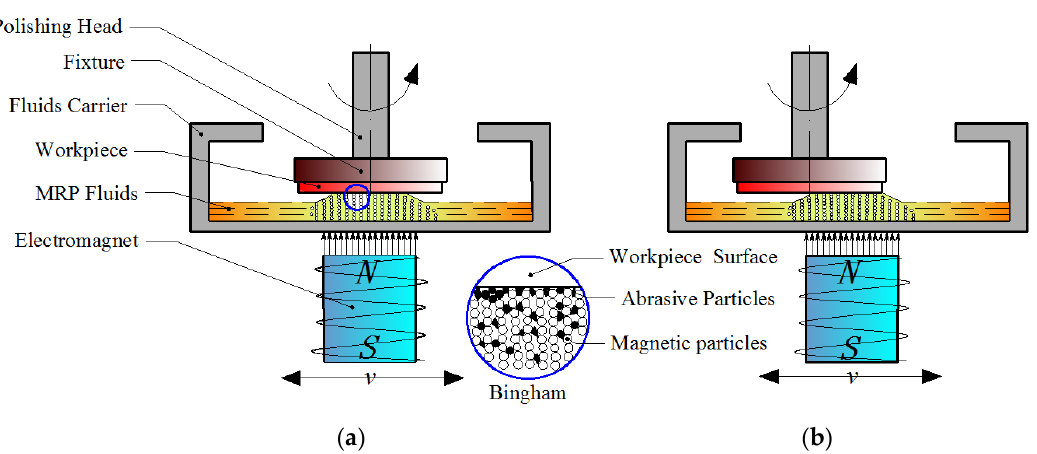
Figure 1. Principle diagram of the reciprocating magnetorheological polishing (RMRP): ( a ) the processing area at the center area of the workpiece; ( b ) the processing area at the edge area of the workpiece.